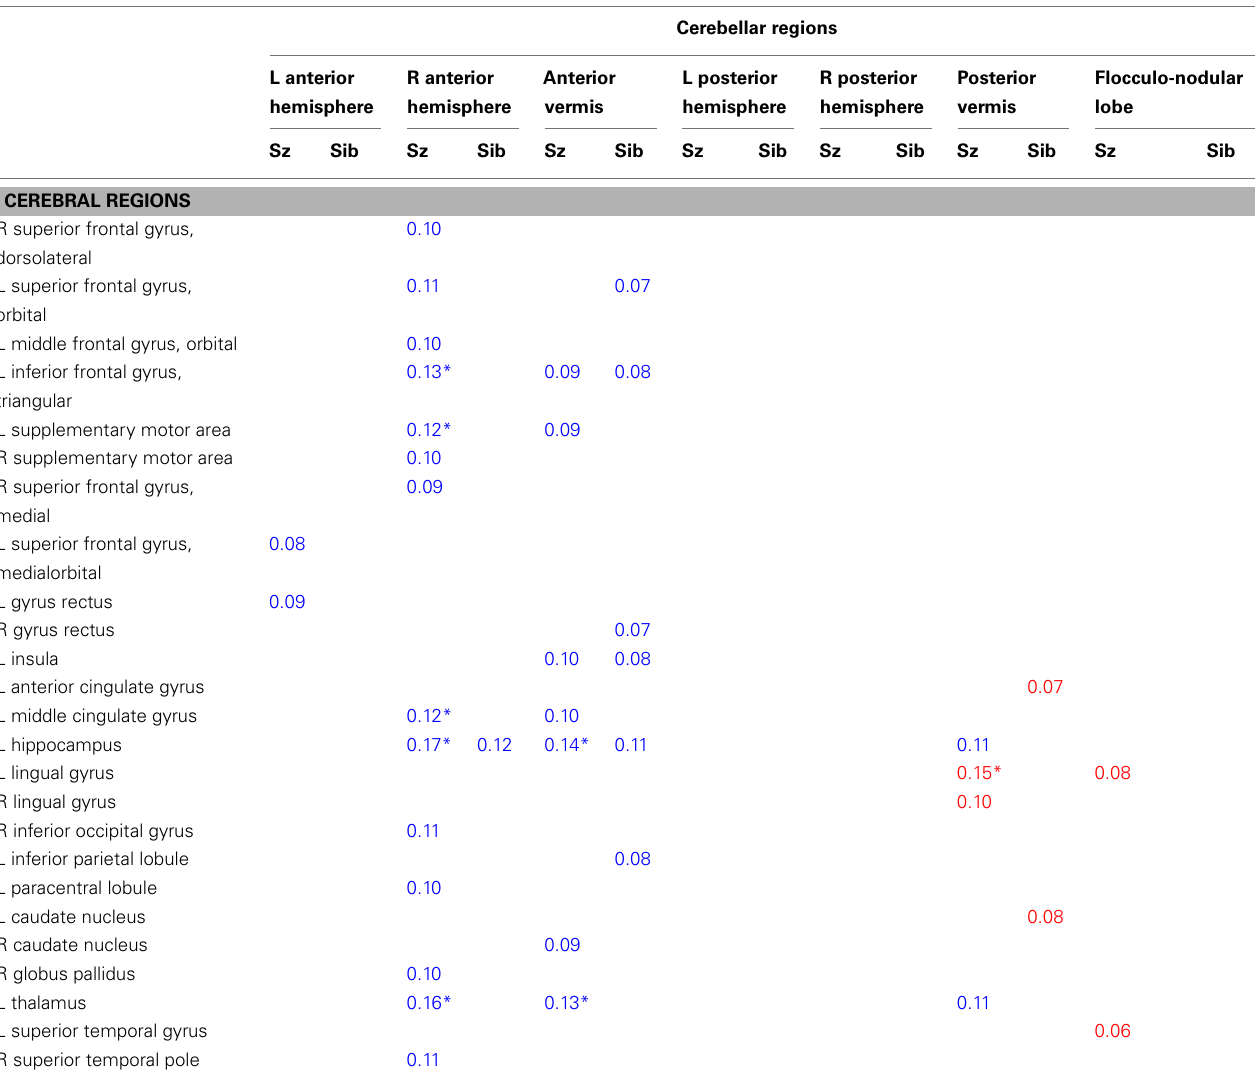
Table 3 |Absolute differences in functional connectivity between subject